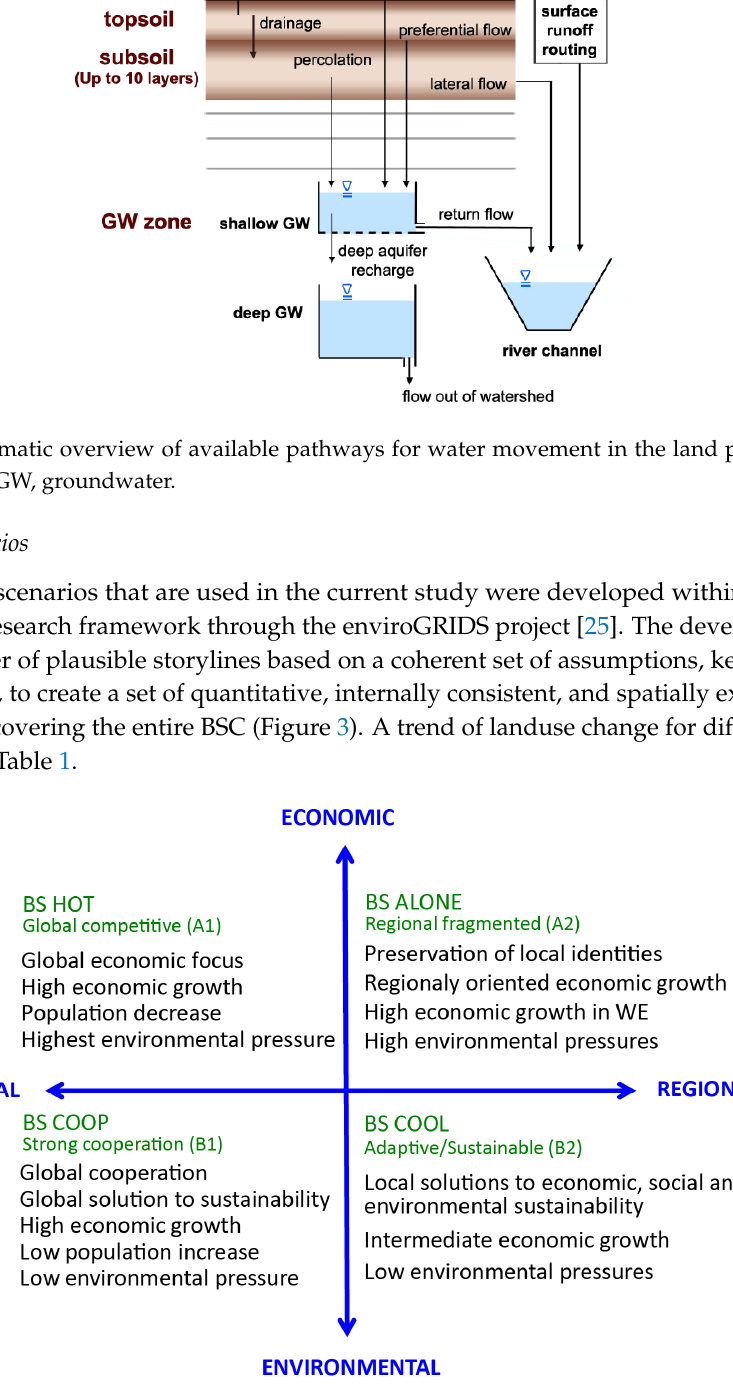
Figure 3. Black Sea Catchment’s landuse scenarios. BS, Black Sea.